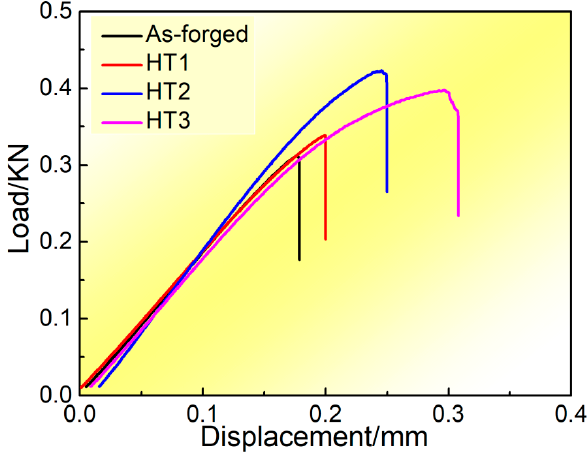
Figure 6. Load–displacement curves from the fracture toughness test of composites under different conditions. Table 4. Fracture toughness (K IC ) values for the 7.5 vol.% TiB w /Ti composites under different